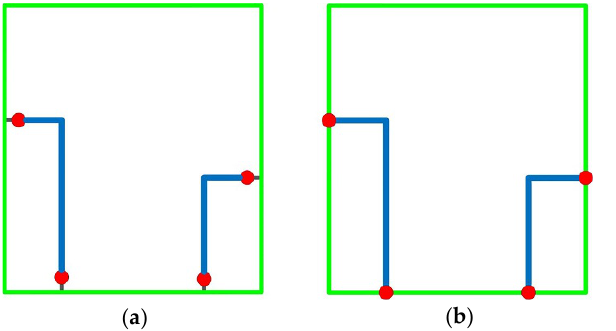
Figure 6. Top view of extending the endpoint of the non-overlapping region to the nearest plane: ( a ) the two endpoints (red circle) before extension; ( b ) the two endpoints after extension. Figure 5. Illustration of the robust cuboid fitting segmentation: ( a ) top view of the model component; ( b ) fitting result.